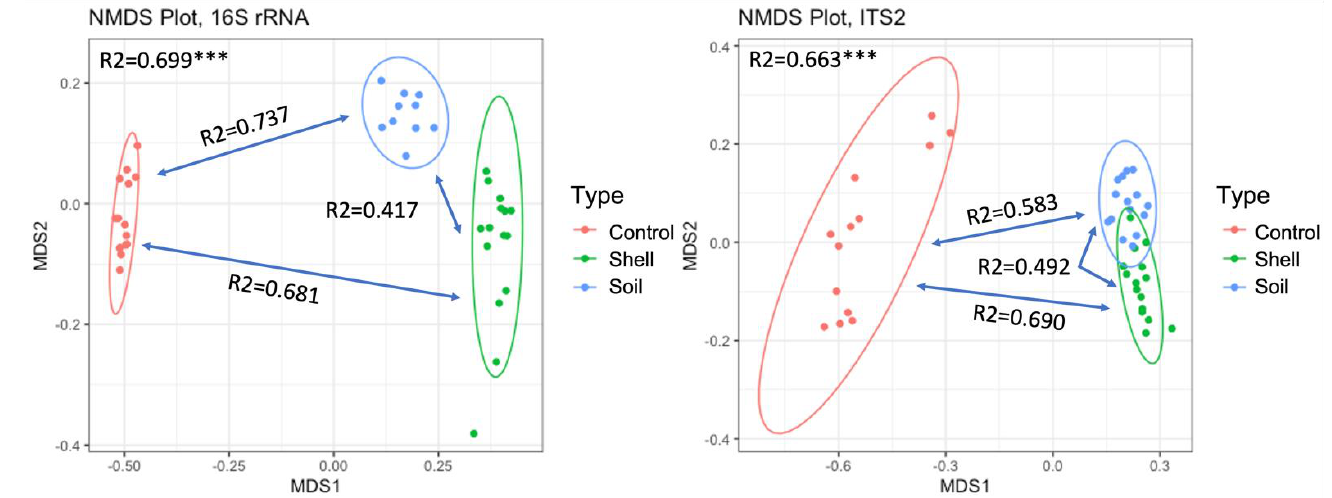
Figure 1. Nonmetric multidimensional scaling (NMDS) of bacterial and fungal communities at ASV level. The difference between communities based on Bray-Curtis distance Adonis tests was used to assess whether beta-diversity is related to sample groupings, 999 permutations, R2, *** p <